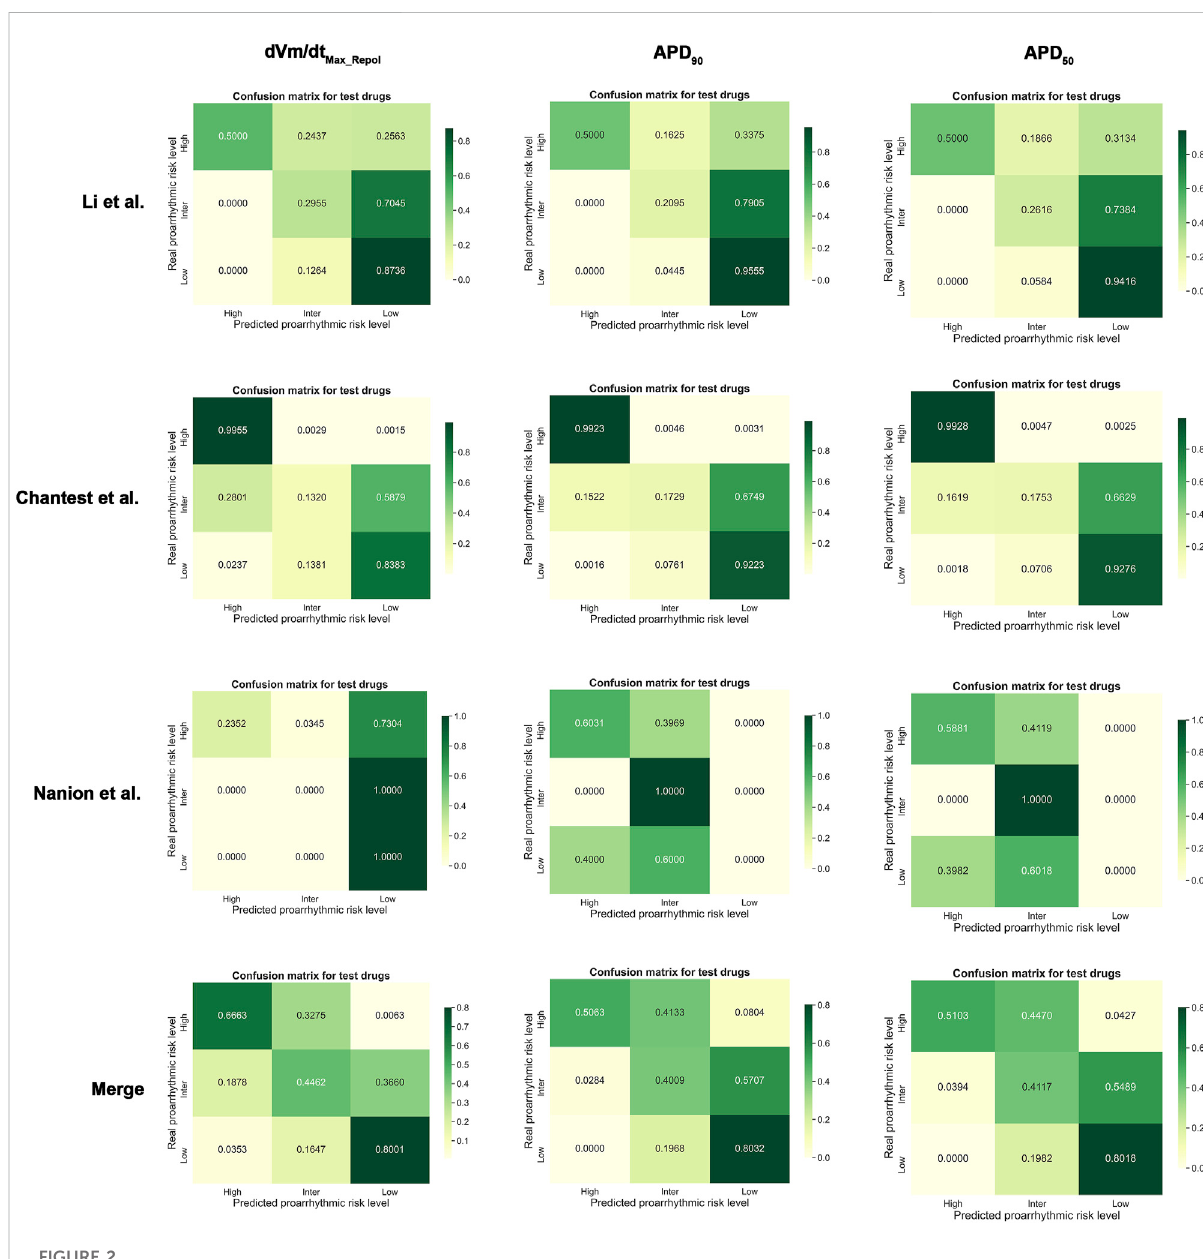
FIGURE 2 Normalized confusion matrices for dVm/dt Max_repol , APD 90 , and APD 50 ; Merged, the combined set containing all three